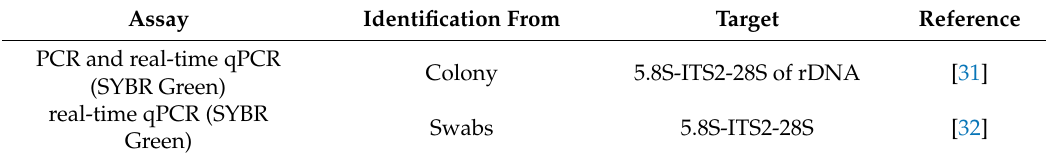
Table 2. Molecular-based methods for the identification of Candida